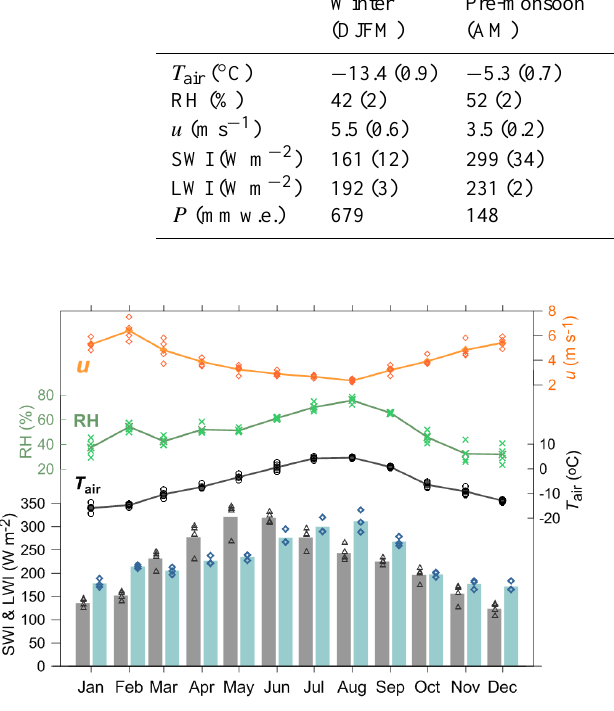
Figure 4. Mean monthly values of T air (black dots), RH (green crosses), u (orange squares), SWI (grey bars) and LWI (light blue-green bars) at AWS2 (4863ma.sl.). T air , RH, u and SWI are the mean monthly values of 4 hydrological years between 1 October 2009 and 30 September 2013 while LWI are the mean monthly values of 3 hydrological years between 1 October 2010 and 30 September 2013. Also shown are the monthly values of T air (black circles), RH (light green crosses), u (orange hollow squares), SWI (black hollow triangles) and LWI (blue hollow squares) used to derive the mean monthly